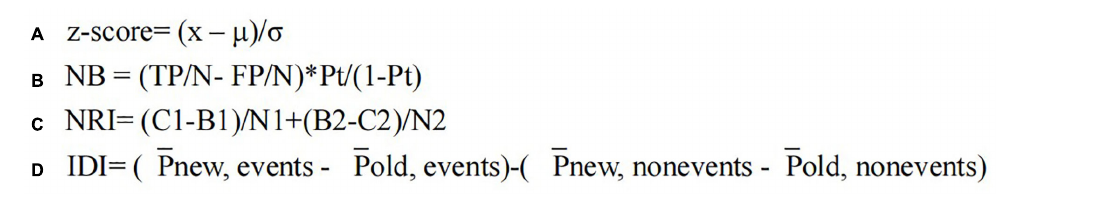
Figure 1C ) and total integrated discrimination index